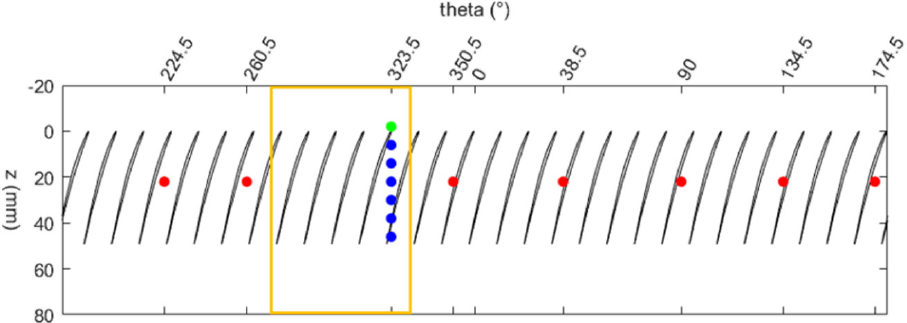
Figure 2. Scheme representing rotor blades and pressure probe locations highlighted in red (mid chord circumferential positions) and blue (axial position from z = − 2 mm to z = 50 mm); probe used for DMD (green), wake of the grid (yellow).